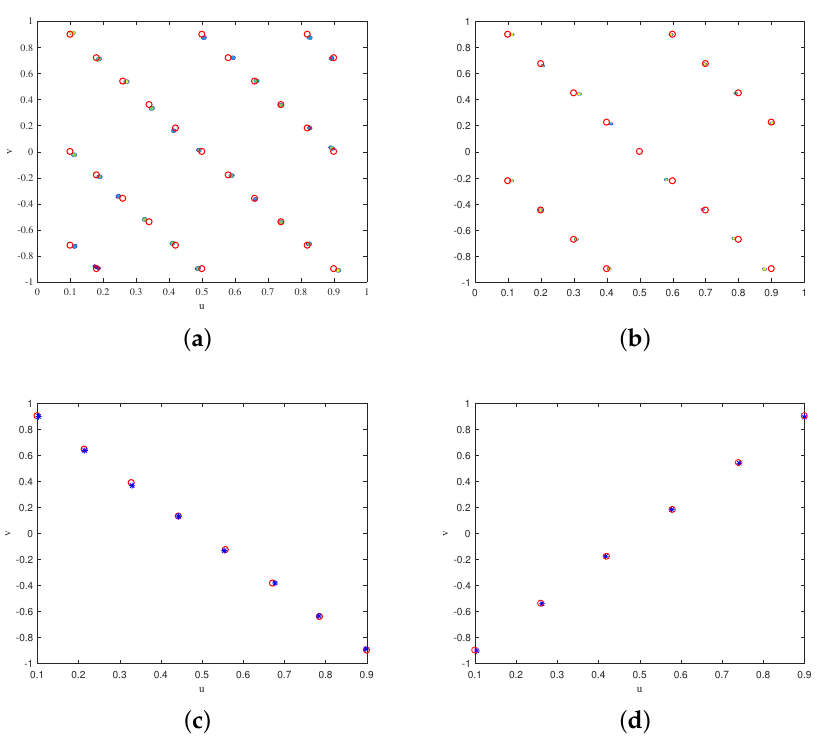
Figure 5. ( a ) Contour map of the proposed algorithm. ( b ) Contour map of the TNNR algorithm. ( c ) Estimated 2-D DOA with standard URA. ( d ) Estimated 2-D DOA of the ISR